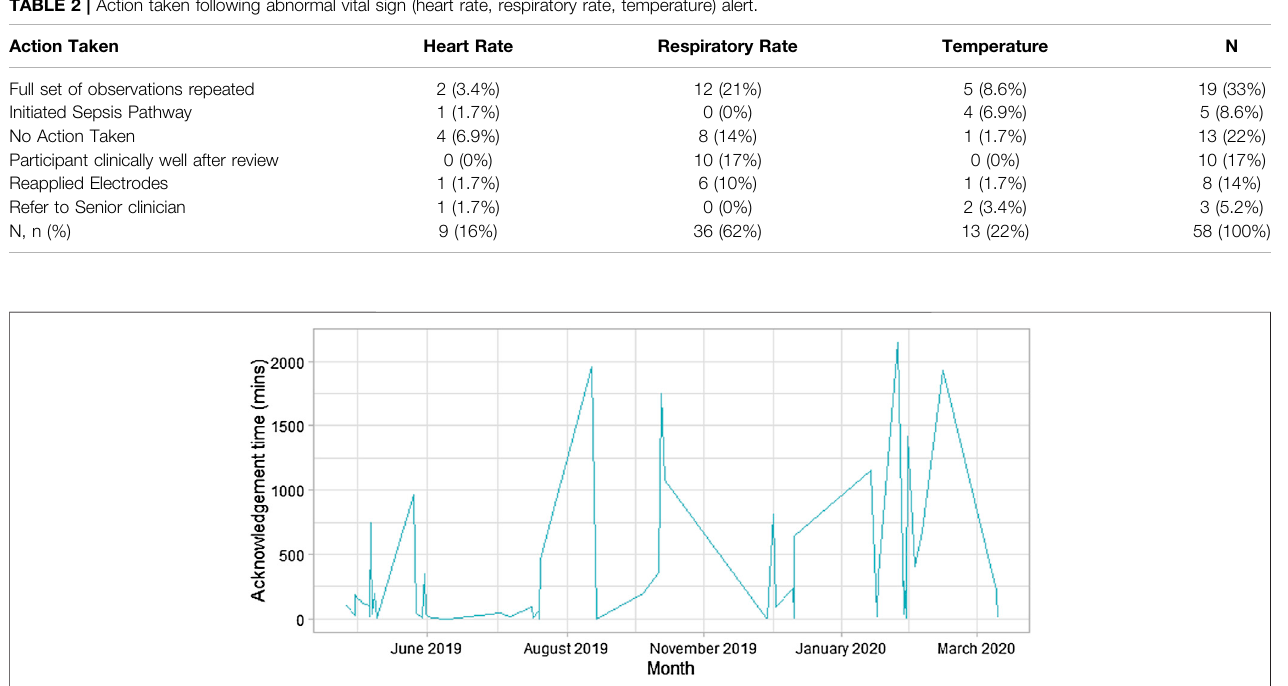
FIGURE 3 | Time series displaying the alert acknowledgement time by healthcare